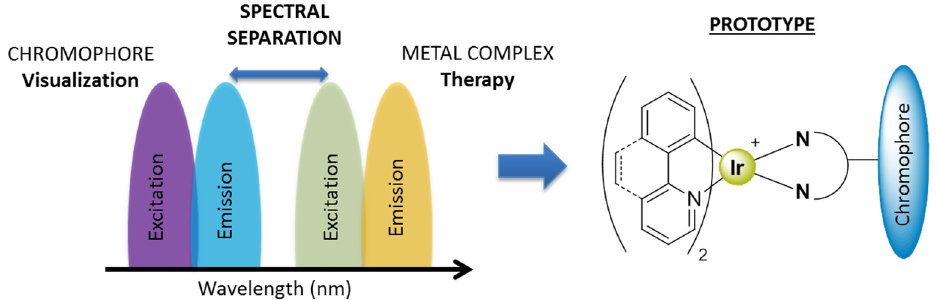
Figure 2. Depiction of the devised dual emissive Ir(III)